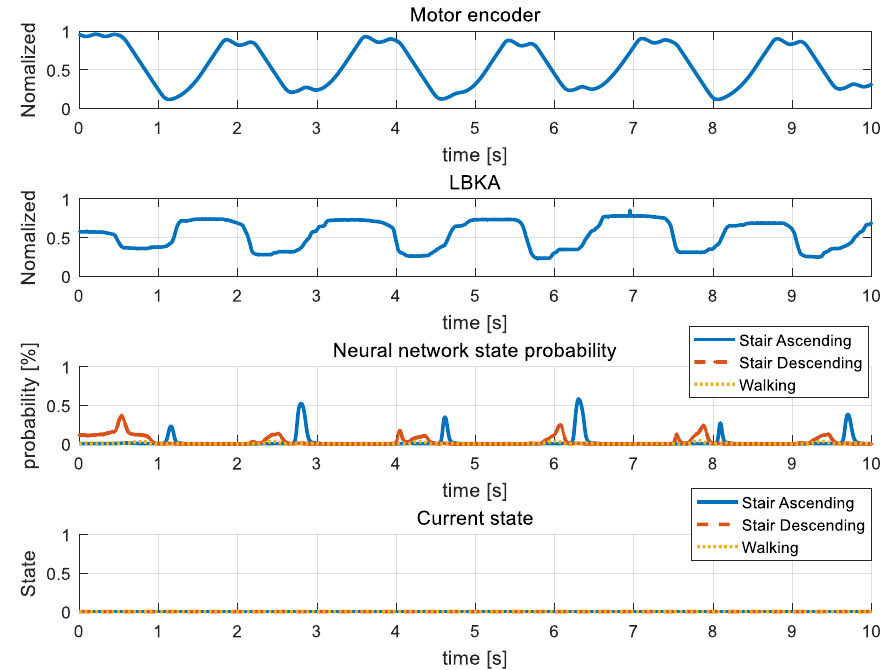
Figure 19. Similar pattern input experiment. We entered sensor data that could be confused with other states by wearer bending the legs repeatedly.